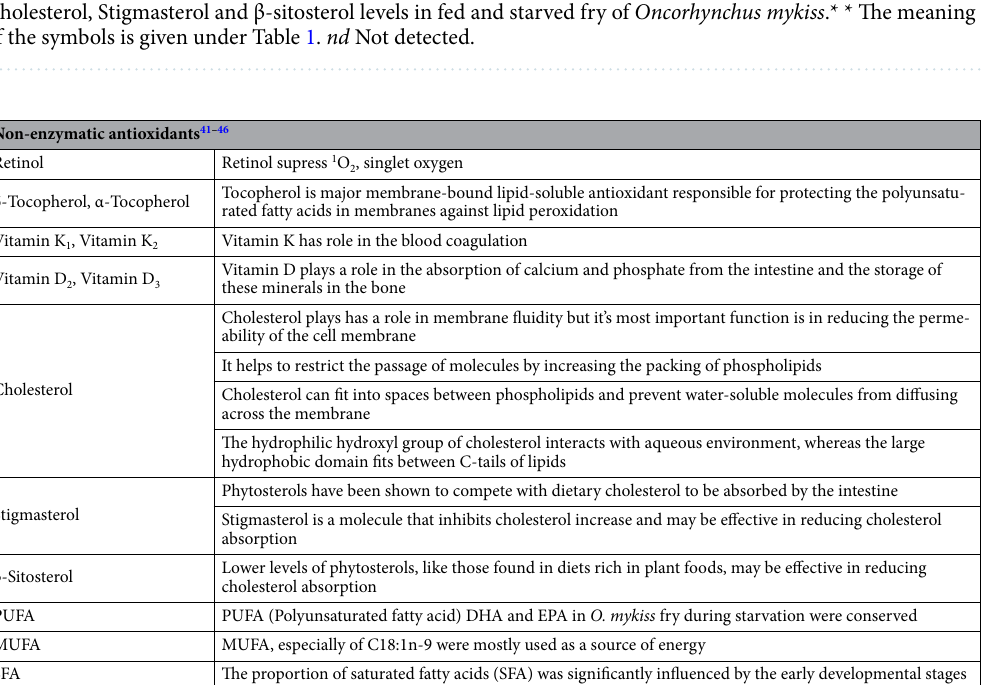
Table 4. Changes in Retinol, Vitamin D 2, Vitamin D 3 , Vitamin K 1 , Vitamin K 2 , δ-Tocopherol, α-Tocopherol, Cholesterol, Stigmasterol and β-sitosterol levels in fed and starved fry of Oncorhynchus mykiss .* * The meaning of the symbols is given under Table 1. nd Not detected.